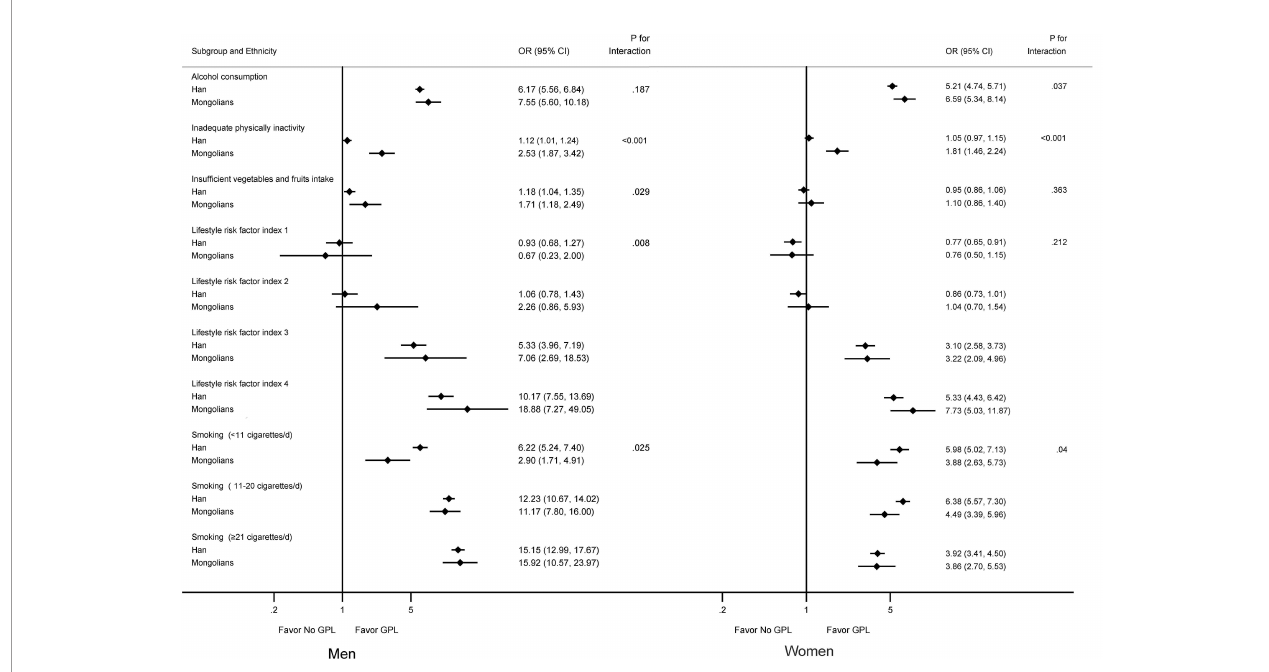
FIGURE 1 | Multivariable-adjusted odds ratios for GPL by lifestyle factors grouped by sex and ethnicity. Smokers were de fi ned as those who had smoked ≥ 1 cigarette (or equivalent) per day for at least 6 months. Alcohol consumption was de fi ned as drinking alcohol at least once a week on average for more than 6 consecutive months. Model was adjusted for age, education, occupation, body mass index, and family history of gastric cancer. P-value of interaction between sex and ethnicity. OR, odds ratio. CI, con fi dence interval. GPL, gastric precancerous